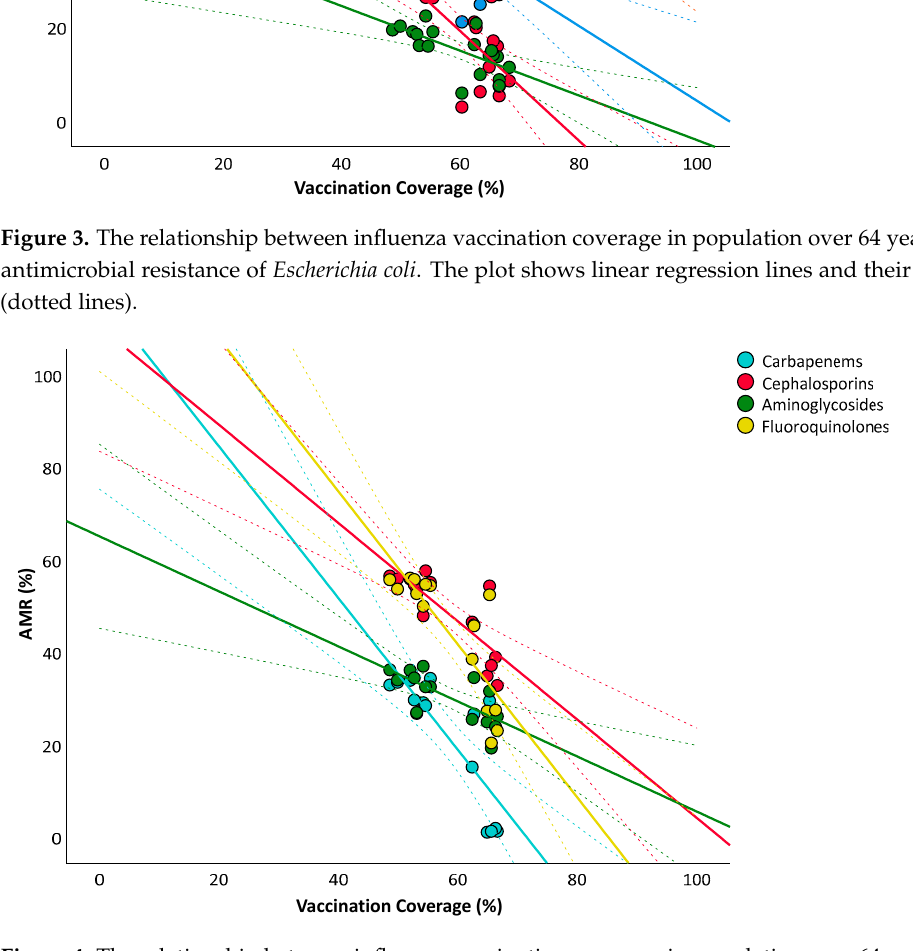
Figure 4. The relationship between influenza vaccination coverage in population over 64 years and antimicrobial resistance of Klebsiella pneumoniae . The plot shows linear regression lines and their 95% CI (dotted lines).